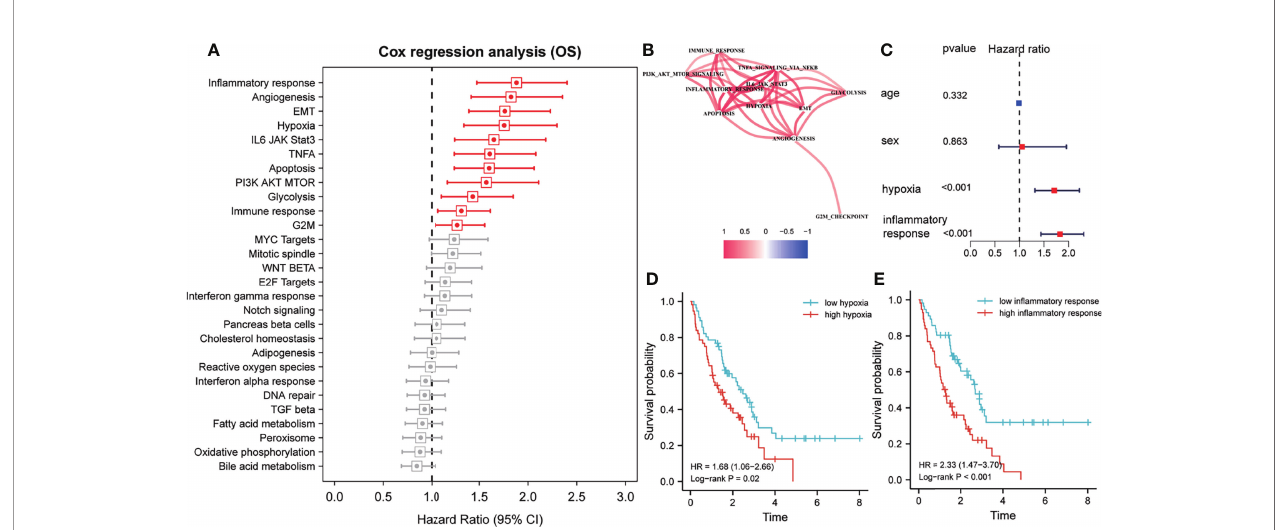
FIGURE 1 | In fl ammatory response and hypoxia are dominant risk factors for patients with idiopathic pulmonary fi brosis (IPF) in the training cohort. (A) Univariate Cox regression analysis for the prognostic value of various hallmarks. Red, p < 0.05; grey, p > 0.05. (B) Spearman correlation analysis was performed to construct a correlation network for prognosis-related hallmarks. (C) Multivariate Cox regression analyses of clinical factors and the in fl ammatory response and hypoxia-related signature. (D) Kaplan – Meier survival analysis of the single-sample gene set enrichment analysis (ssGSEA) score of hypoxias for overall survival. (E) Kaplan – Meier survival analysis of the ssGSEA score of in fl ammatory response for overall survival.